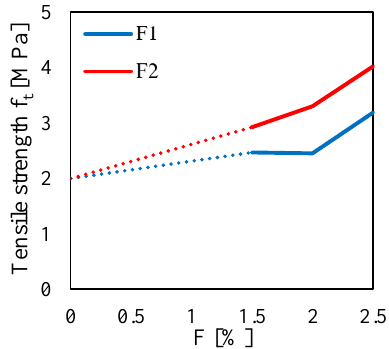
Figure 9. Tensile strength f t measured in the BTs for two fiber type (F1 and F2) with different fiber